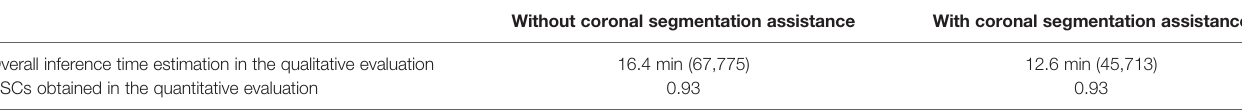
TABLE 6 | Inference time estimation and DSCs obtained with and without coronal segmentation